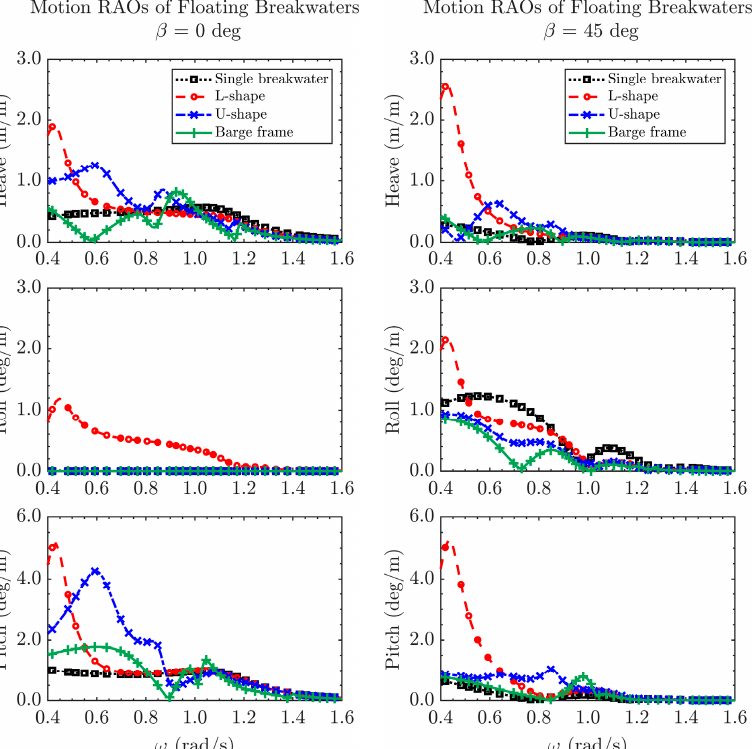
Figure 7. Motion RAOs of the floating breakwaters of different configurations in heave, roll, and pitch in 0 and 45 deg incident wave directions.